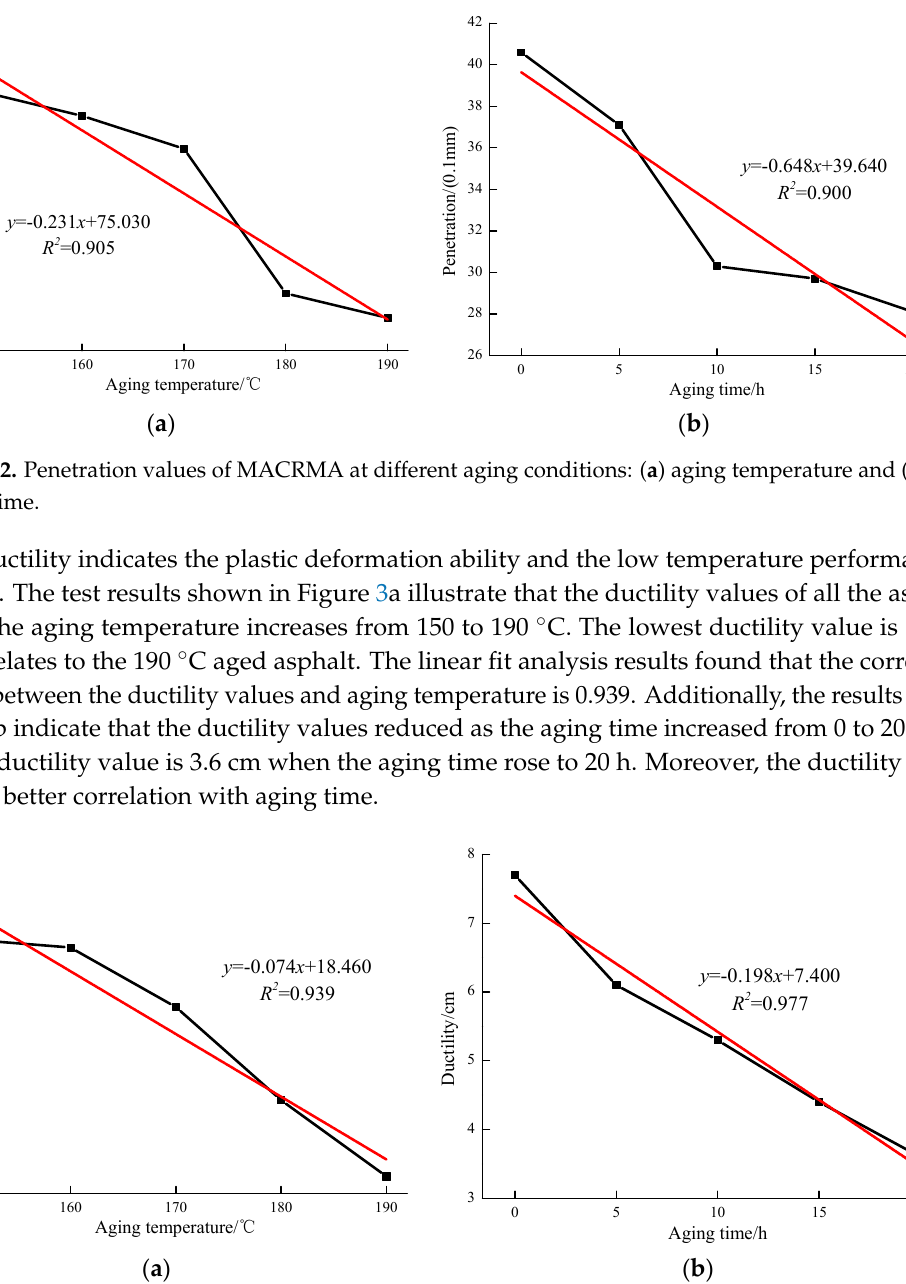
Figure 3. Ductility values of MACRMA at different aging conditions: ( a ) aging temperature and ( b ) aging time.